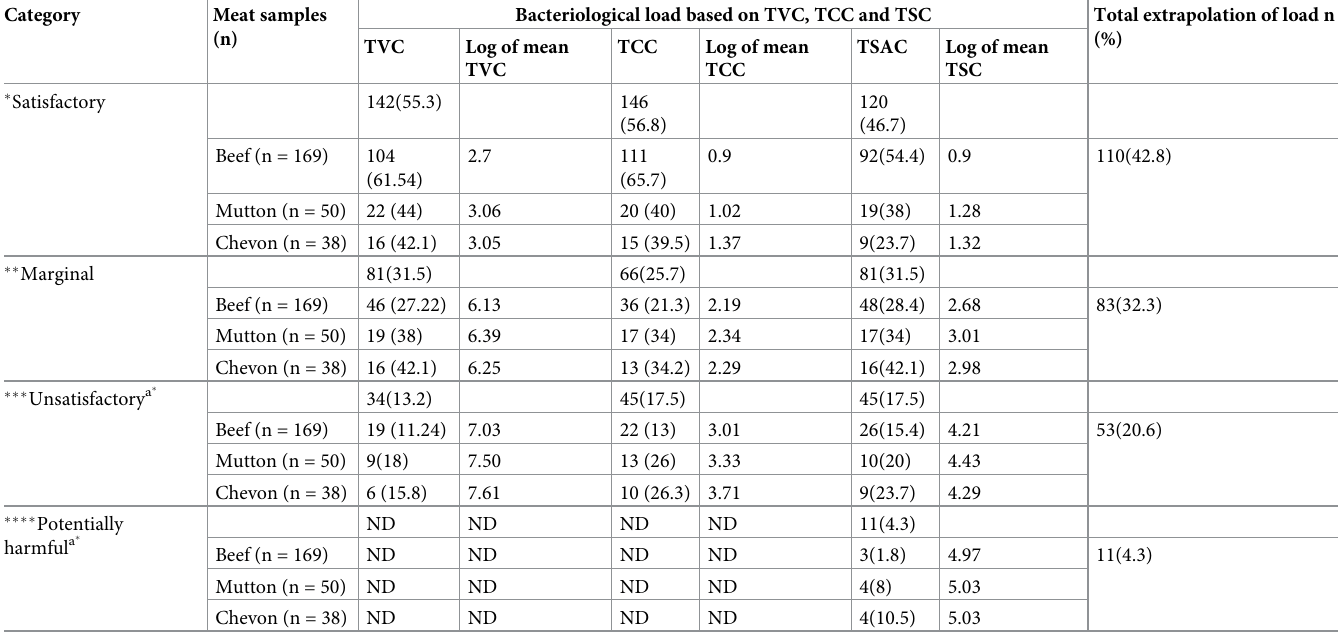
Table 1. Bacteriological load of different types of RTE raw minced meats served in hotels and restaurants of Arba Minch town from 01 July to 31 December, 2020. Category Meat samples Bacteriological load based on TVC, TCC and TSC (n)